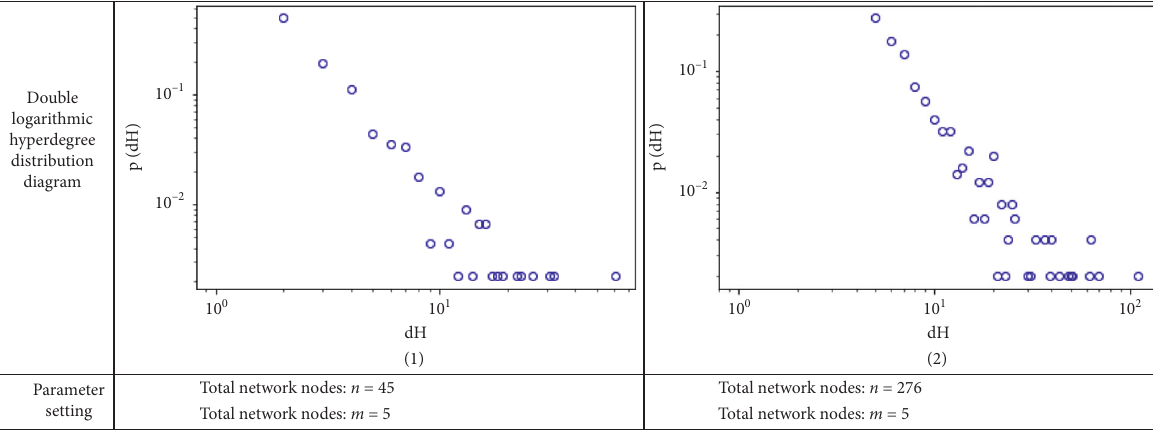
Figure 9: Hyperdegree distribution diagram of different